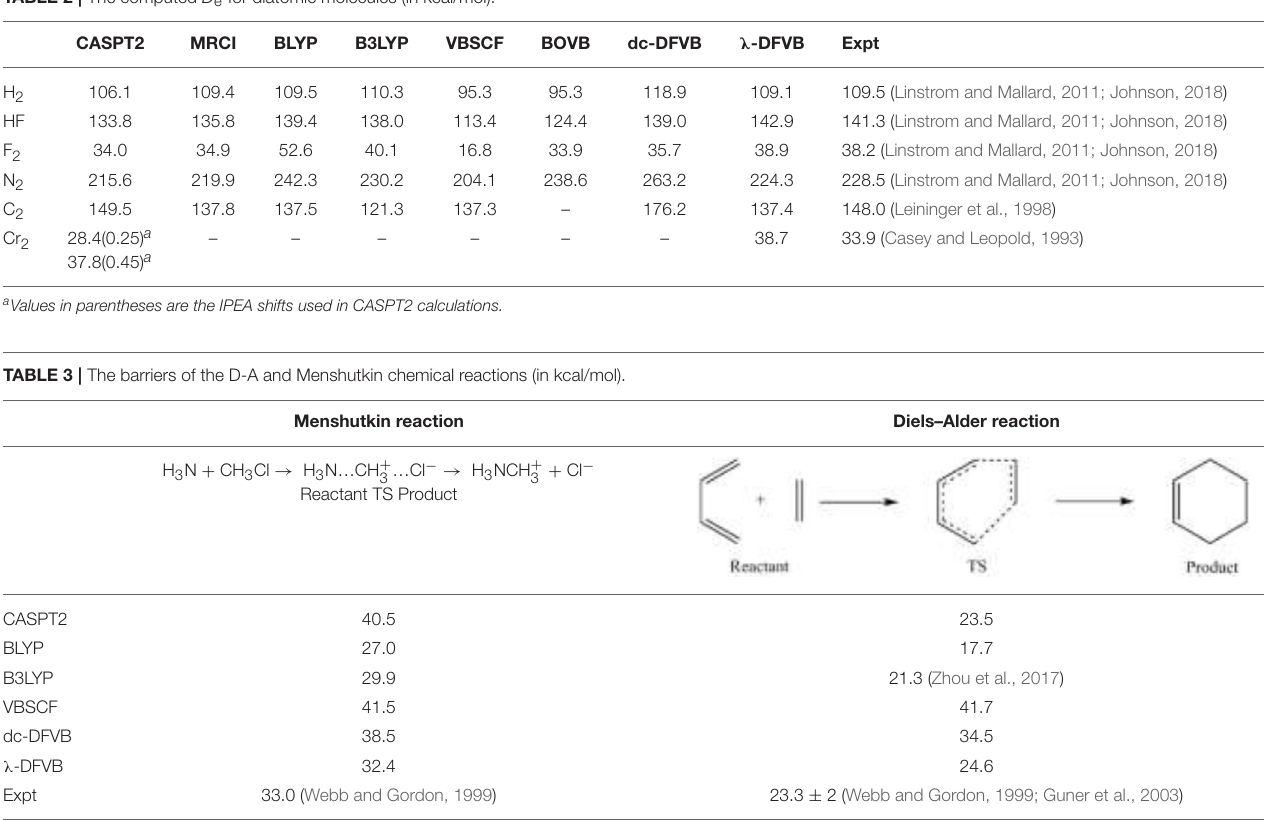
TABLE 2 | The computed D e for diatomic molecules (in kcal/mol).